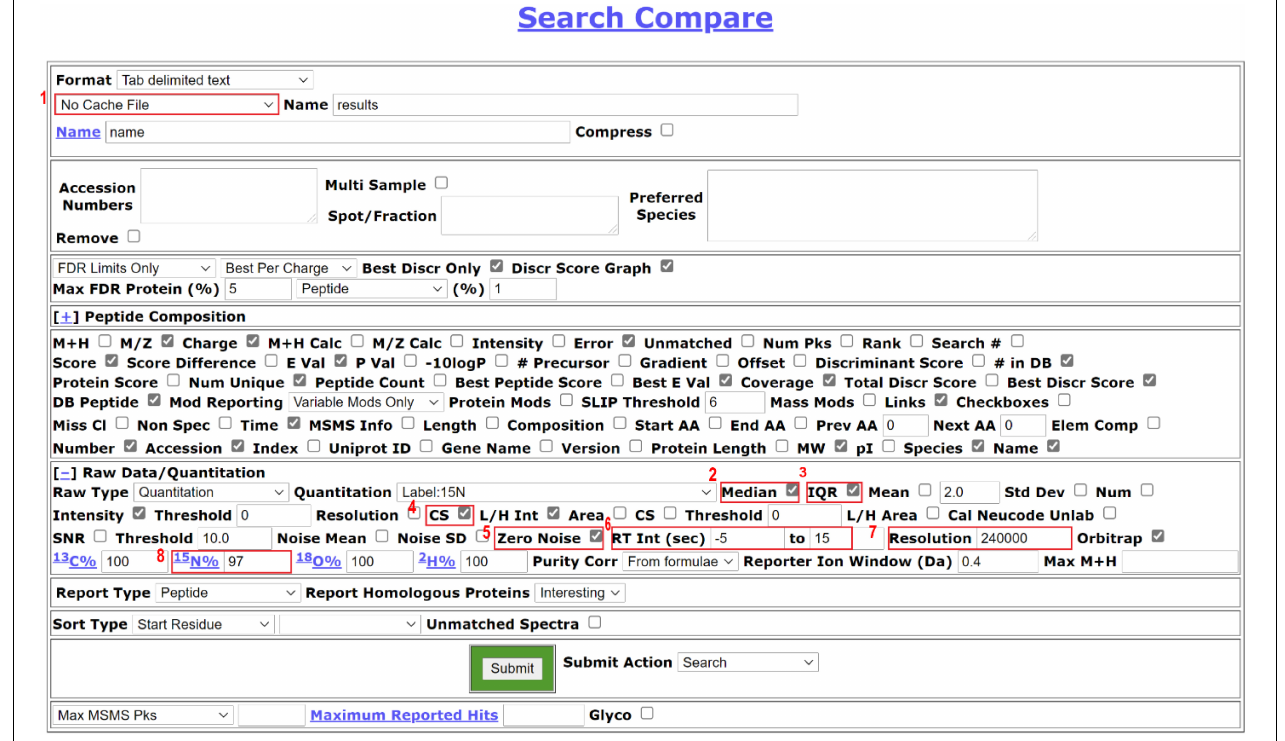
FIGURE 3 | Search Compare parameters suitable for 15 N quantification. The users can generate different formats of reports depending on the next step analysis. Users can choose a cache function in the drop-down, as highlighted in [1], which allows the users to store the analysis result and retrieve the analysis data quickly in the future. For protein quantification, we recommend checking median [2] and IQR [3] to report a median ratio of peptides for a protein and the interquartile range. CS score [4] is selected to check the quality of the match to the isotope cluster. Zero noise [5] should be checked for high-resolution MS 1 data so the PP will not impute numbers based on the local noise level. Retention (RT) interval between –5 to 15s [6] is the window before and after when the MS 2 scan was acquired to use for averaging MS1 spectra before calculating peak ratios. The intensity of the respective peptides is averaged across the window and the L/H ratio is reported. Resolution [7] and labeling efficiency [8] are manually filled based on the resolution setting for the MS 1 data in the instrument settings and the data labeling efficiency decided in the previous step of this workflow,